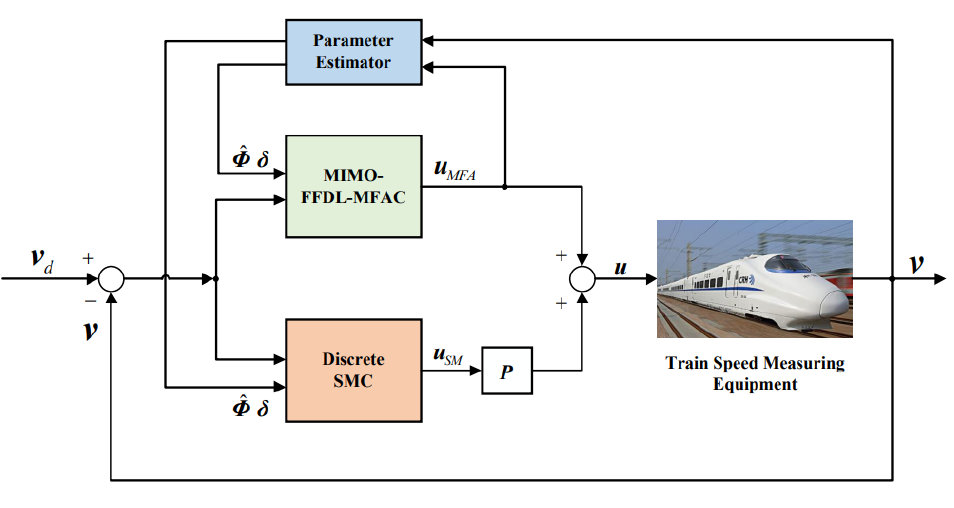
Figure 3. An improved block diagram of MFASMC structure for